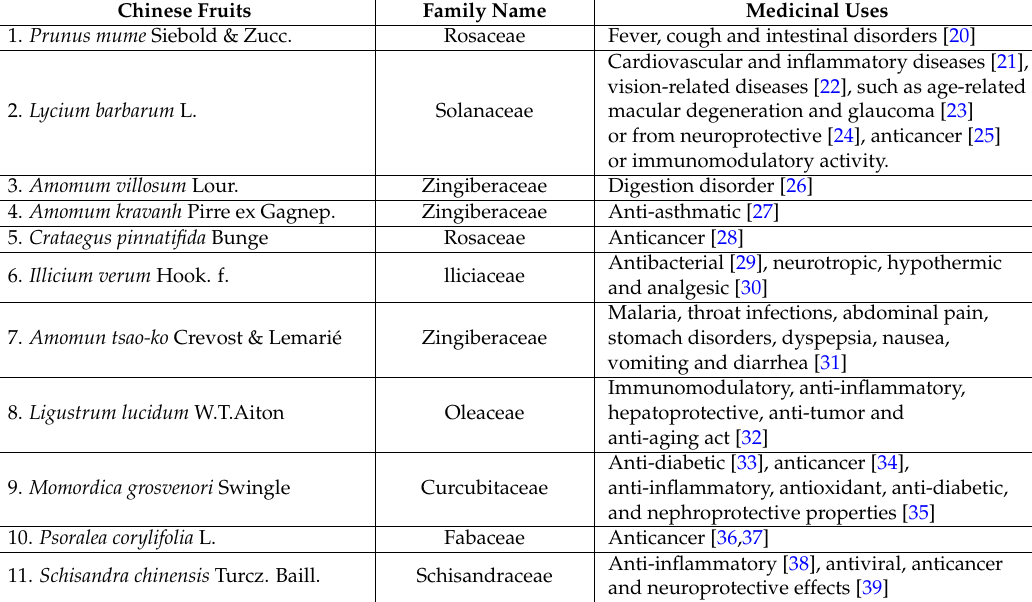
Table 1. List of medicinal fruits used in this